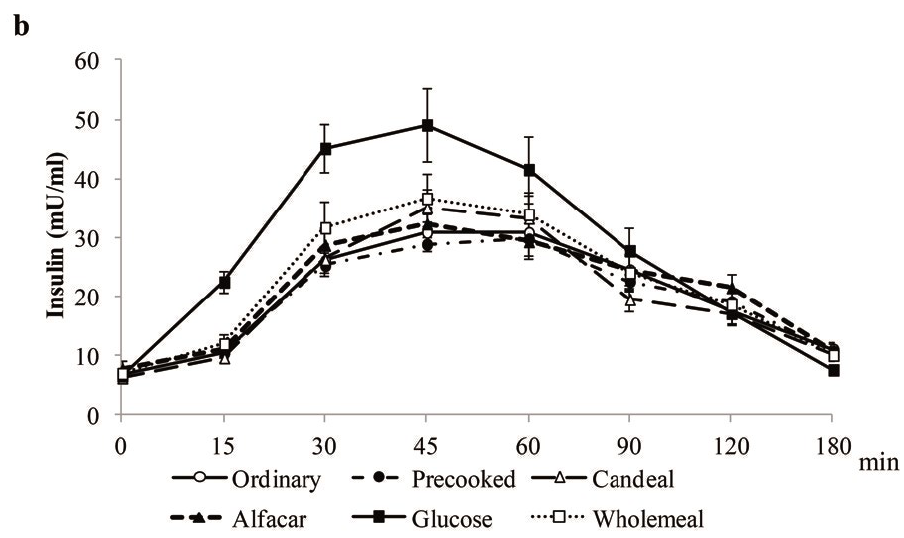
Figure 1. Plasma glucose ( a ) and insulin ( b ) concentrations. Values are expressed as the mean ± SEM ( n = 20); SEM, standard error of the